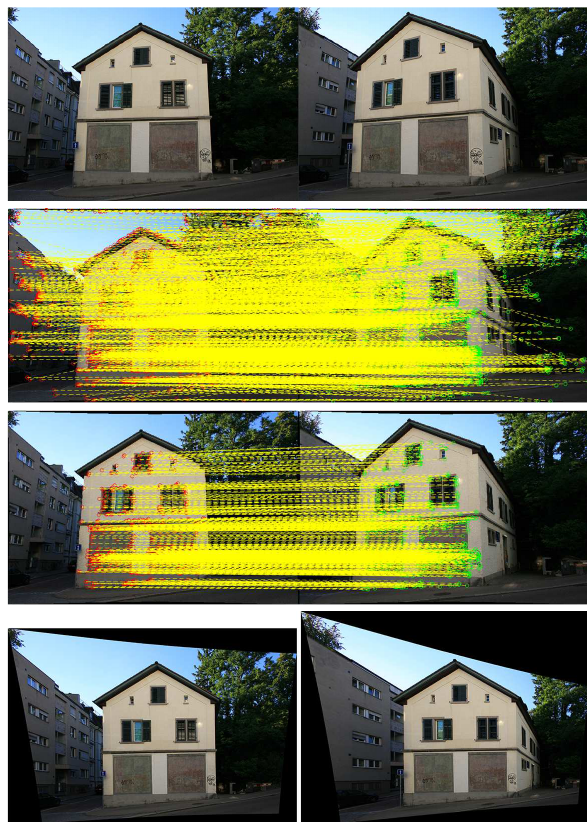
Figure 1. Top row: initial image pair (image axes convergence of 16º). Second row: initial SURF matches (2189). Third row: filtered coplanar points (829). Bottom row: automatically rectified images.